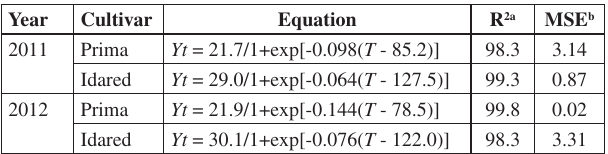
Table 1 Equation, coefficient of determination (R 2 ) and mean square of residuals (MSE) for the three-parameter logistic function describing brown rot development on fruits in three apple cultivars (2011-2012, Mándok,